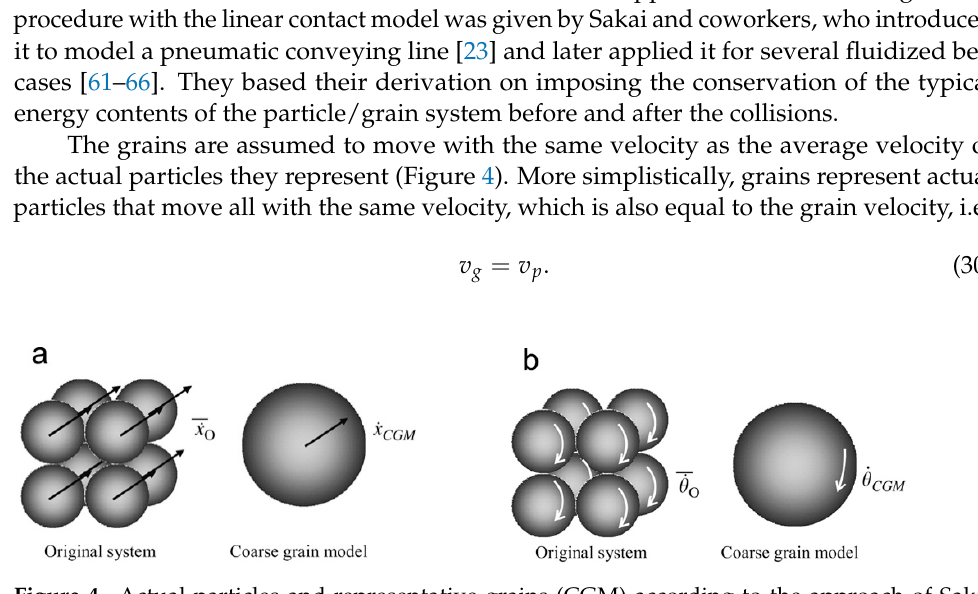
Figure 4. Actual particles and representative grains (CGM) according to the approach of Sakai and Koshizuka [23] for (a) translational and (b) rotational motion. Adapted from Reference [23], with permission from Elsevier.